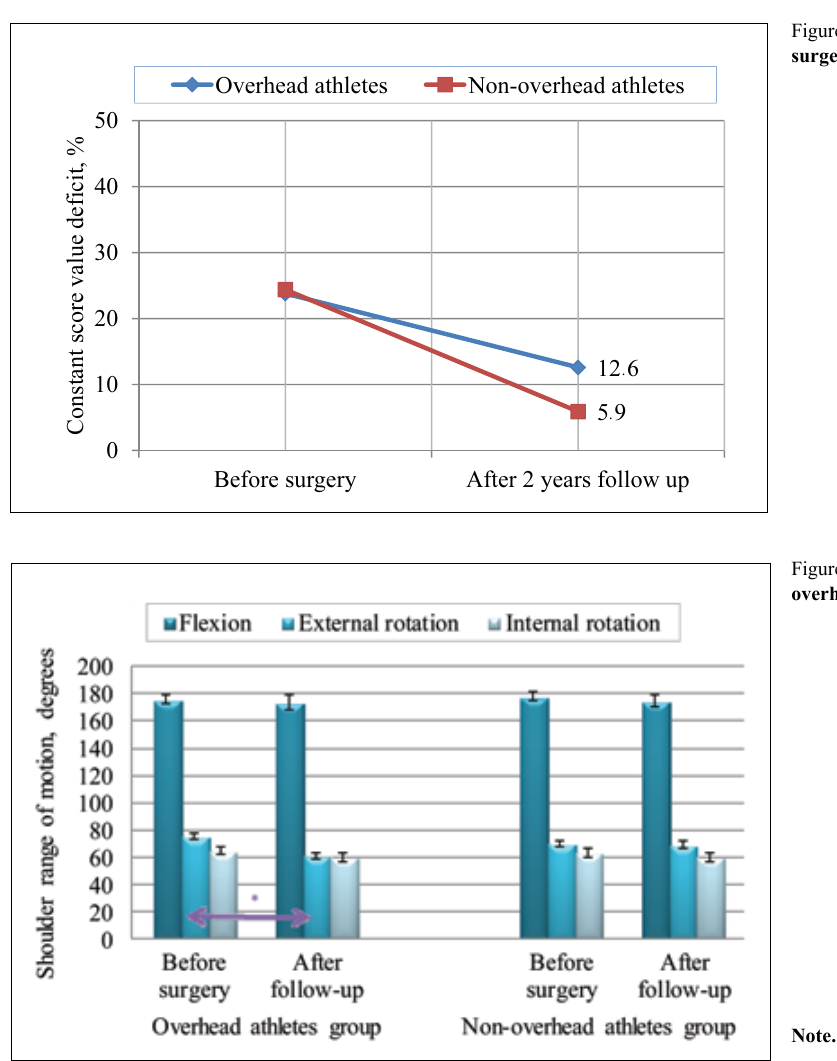
Figure 1. Constant score value deficit before surgery and 2 years after surgery